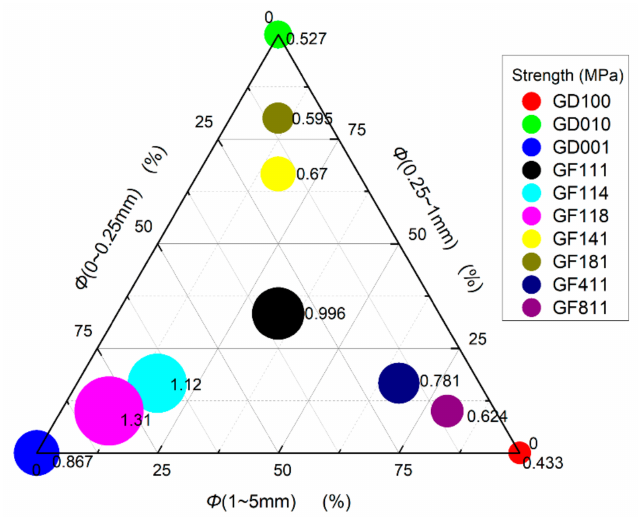
Figure 5. Ternary phase diagram of the uniaxial compressive strength and particle size of tectonic